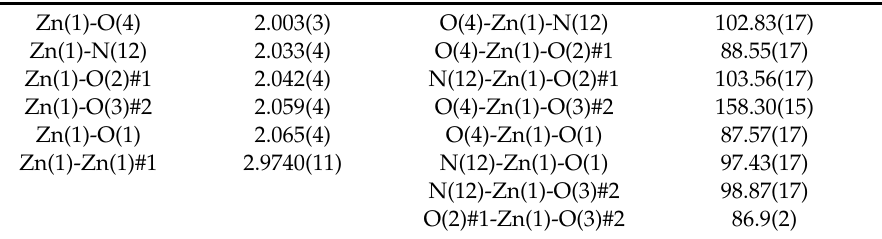
Table 2. The selected bond lengths (Å) and angles ( ◦ ) for compound 1 .